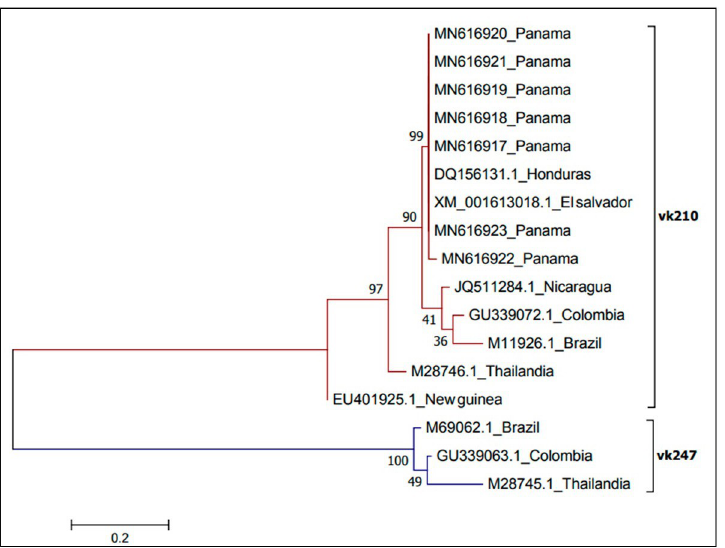
Fig 7. Phylogenetic analysis of P . vivax CSP gene. The phylogeny tree was constructed with the neighbor-joining method with the JTT (John Taylor Torton) model using the MEGA 3 program.